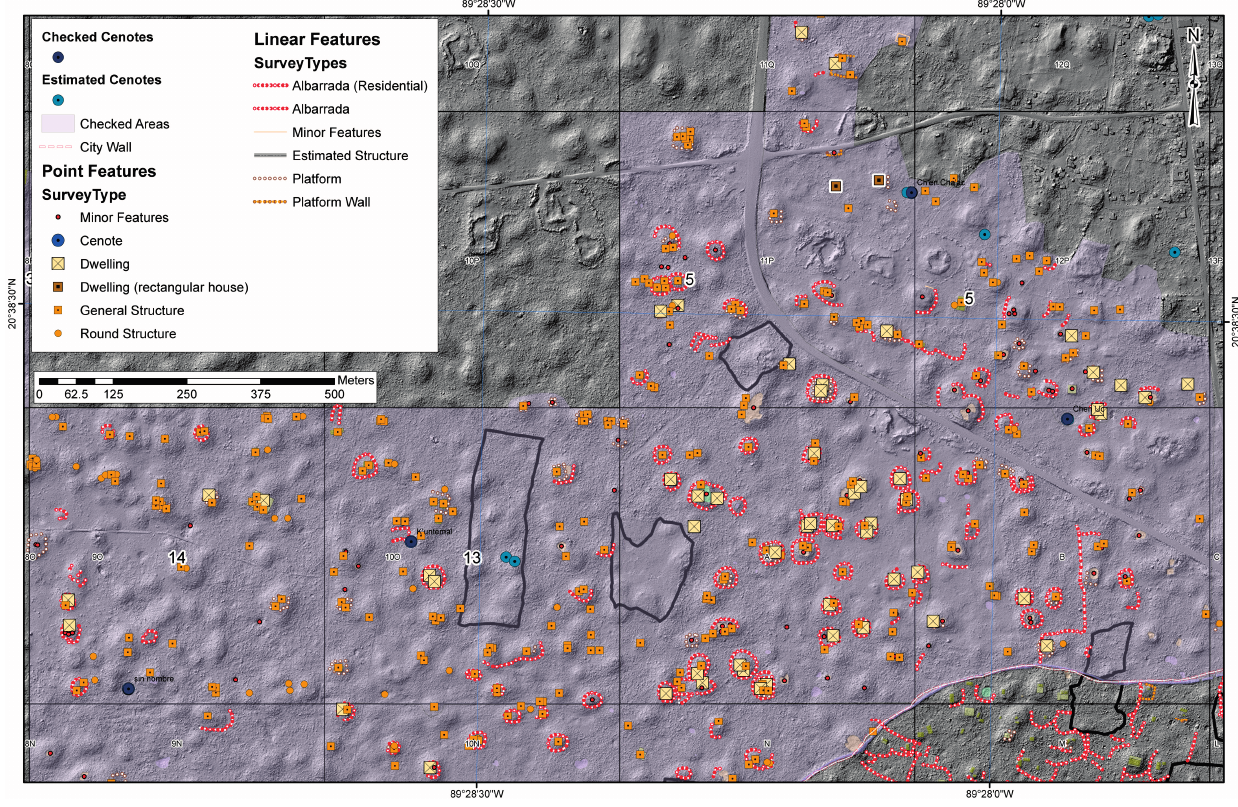
Figure 9. Map of varying density and distance of settlement outside the city